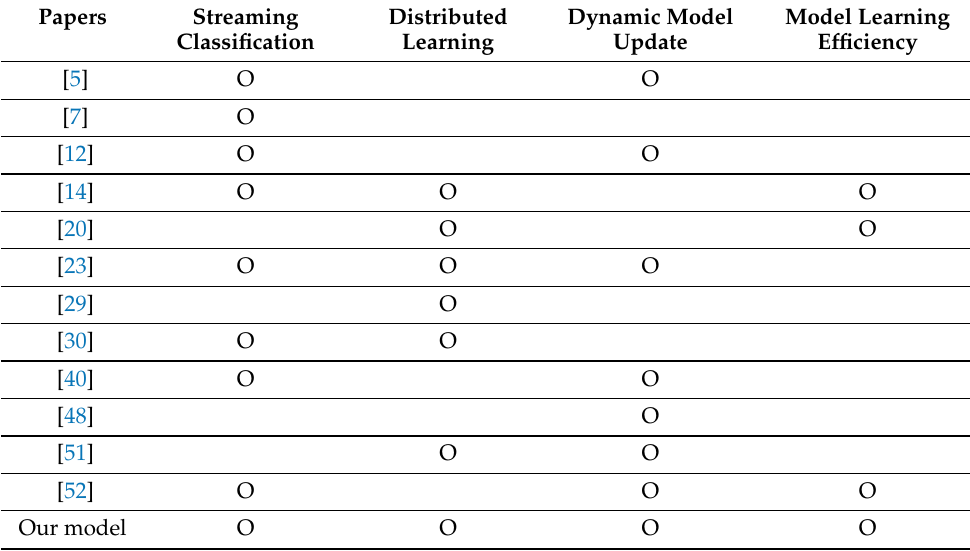
Table 2. Comparison between the previous studies and our